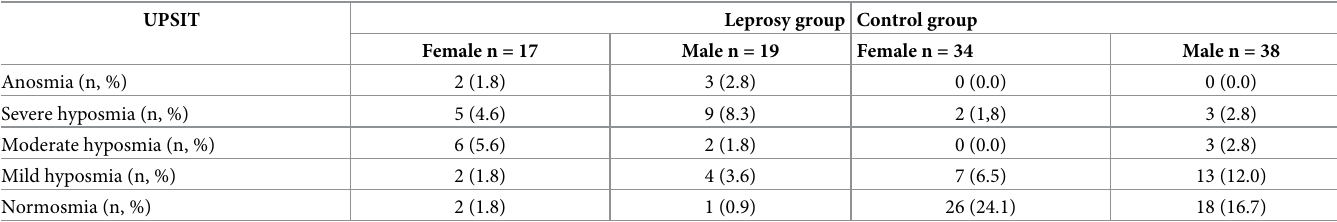
Table 2. UPSIT based on sex distribution (N = 108).